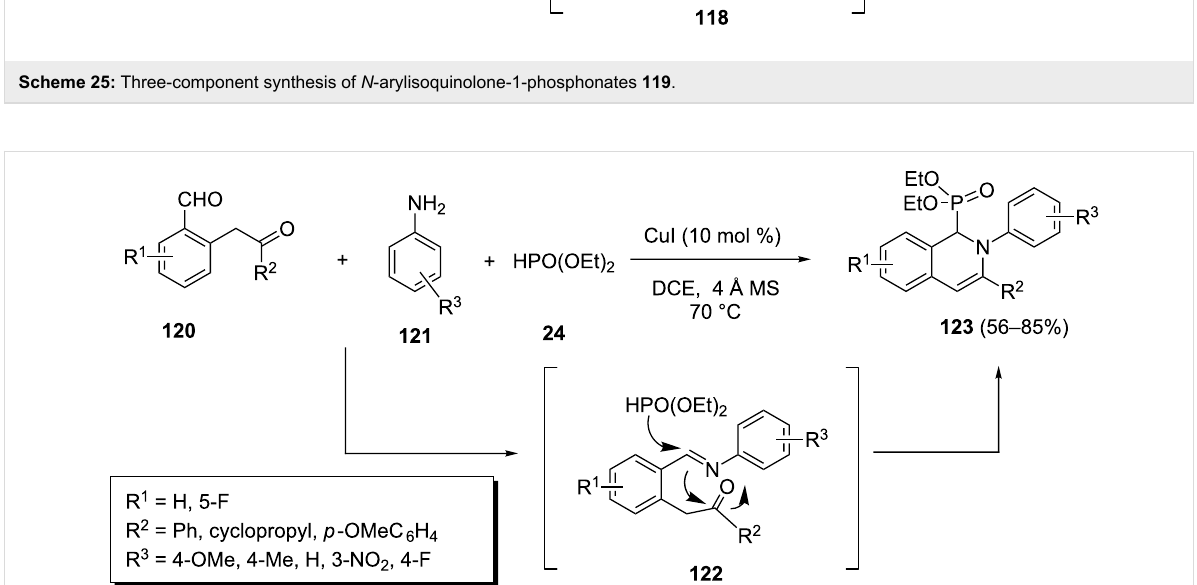
Scheme 26: CuI-catalyzed three-component tandem reaction of 2-(2-formylphenyl)ethanones with aromatic amines and diethyl phosphonate.